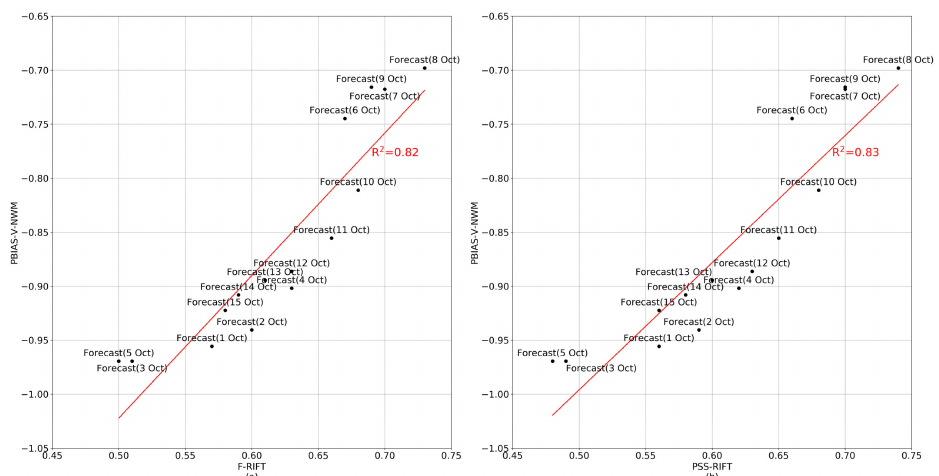
Figure 8. The percent bias of the National Water Model (NWM) streamflow forecasts was compared to the F ( a ) and PSS ( b ) of the simulated maximum flood extents. The red line refers to the linear fit. Abbreviations: PBIAS-V-NWM , percent bias of the total volume of NWM forecast streamflow; F-RIFT , the measure of fit of the maximum flood extents simulated by Rapid Inundation Flood Tool; PSS-RIFT , Peirce’s skill score of the maximum flood extents simulated by Rapid Inundation Flood Tool; R 2 , coe ffi cient of